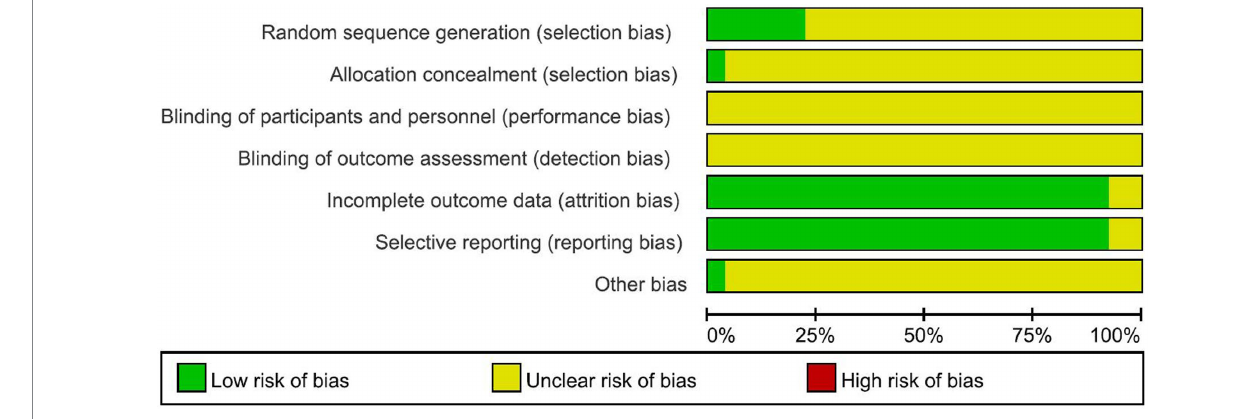
FIGURE 2 Risk of bias evaluation results.